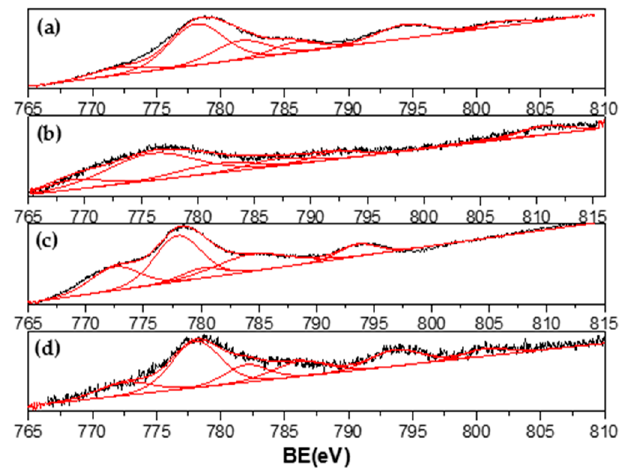
Figure 8. Co 2p XPS spectra of ( a ) Co / La 0.8 Ce 0.2 ; ( b ) Ni 0.1 Co 0.9 / La 0.8 Ce 0.2 ; ( c ) Ni 0.4 Co 0.6 / La 0.8 Ce 0.2 ; and ( d ) Ni 0.7 Co 0.3 / La 0.8 Ce 0.2.